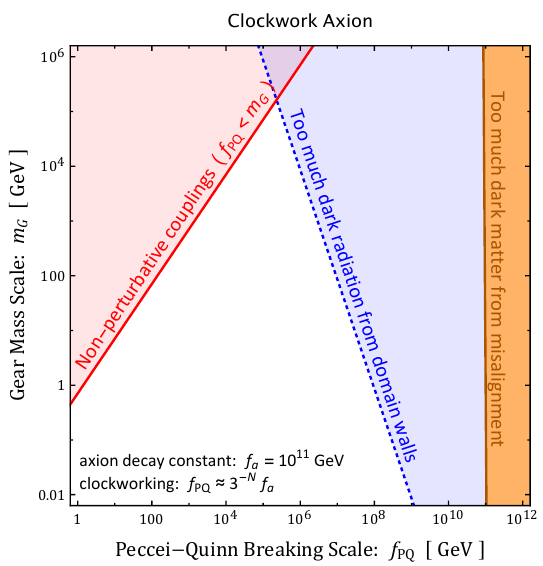
Figure 4 . Parameter space for the clockwork axion model. The red shaded region corresponds to a non-perturbatively large value of the dimensionless coupling, (cid:15) = 2 m 2 region there is too much axion dark matter ((cid:10) a h 2 > (cid:10) with f pq = f a . In this work we have calculated the axion emission from oscillating gear-(cid:12)eld domain walls (3.33), and in the blue region we (cid:12)nd that this produces too much dark radiation ((cid:1) N e(cid:11) > 0 : 1). Uncertainties in this calculation are large and di(cid:14)cult to quantify. Assuming e(cid:14)cient axion emission from small-scale oscillating structure on the gear-(cid:12)eld domain walls ( v ! blue-dotted line is